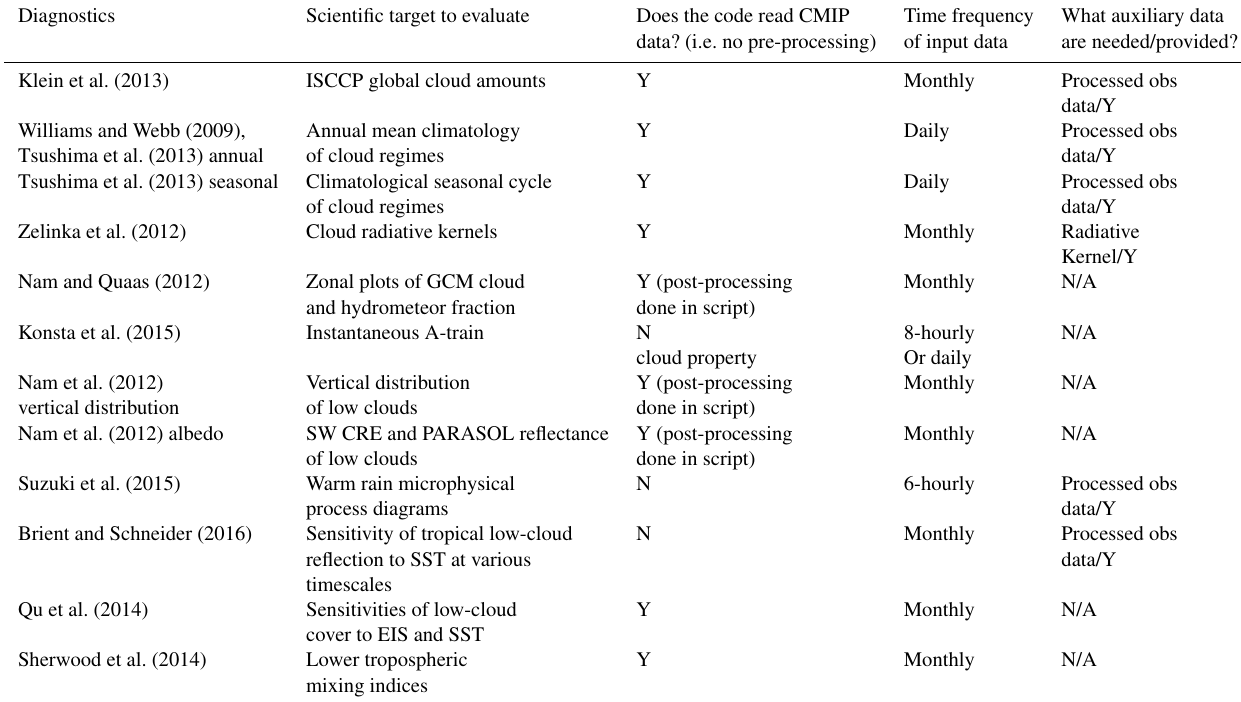
Table 1. A summary table of